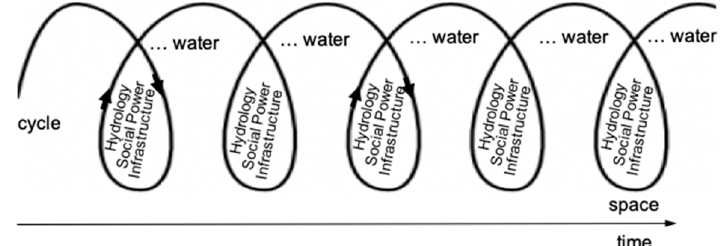
Figure 2. Authors’ interpretation of the hydrosocial cycle, adapted from Linton and Budds [27]. The series of loops reflects process of cyclic remaking of the hydrosocial cycle over time. The relationship between water and society is internal.